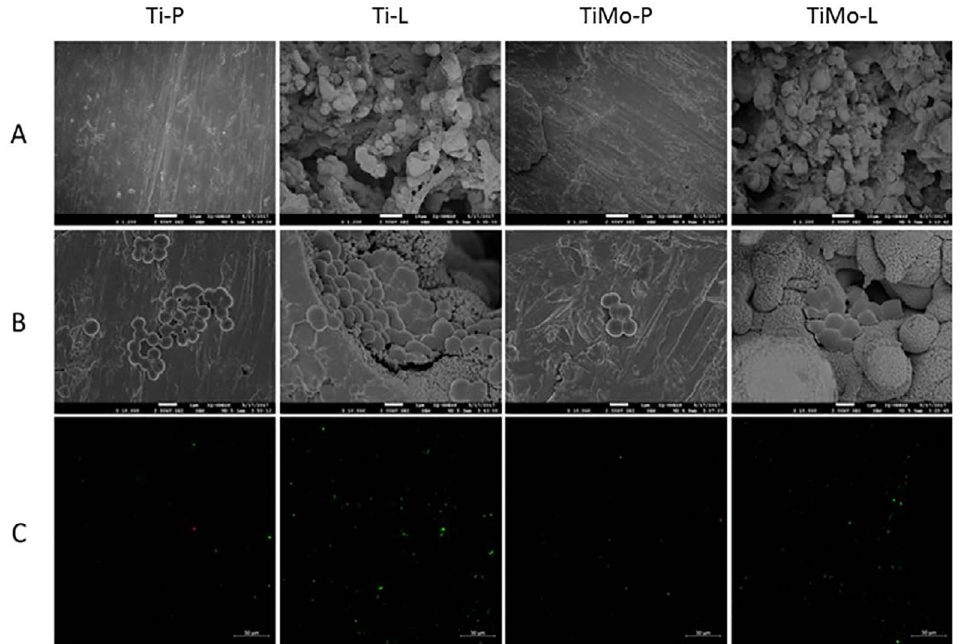
Figure 4. FEG-SEM and CLSM images of MRSA cells adhered to cpTi and Ti-15Mo specimens. (A) FEG-SEM of the surface topography of the groups with different composition. (B) Distribution and morphological characteristics of MRSA on the specimens. (C) CLSM images of living and dead